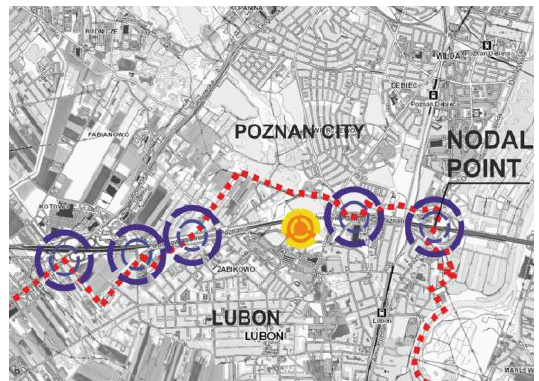
Fig. 1. Administrative boundary between Poznan and Lubon, with the selection of nodal points and illumination of the sacral building (yellow selection) [1, 2] .